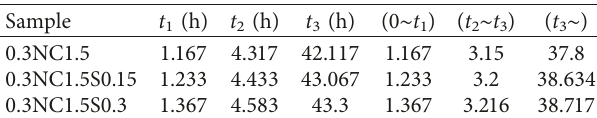
Figure 6: Effects of different SAP dosages on the hydration process. Table 6: The hydration period separation time of cement pastes with different SAP